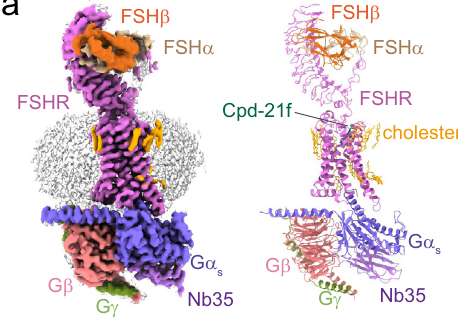
Fig.1|Cryo-EMstructuresoftheFSH-FSHR-GscomplexandtheinactiveFSHR. a Cryo-EM density (left panel) and ribbon presentation (right panel) of the FSH- FSHR-Gs complex,thecomplex density mapisshownatlevel of 0.044. b Cryo-EM